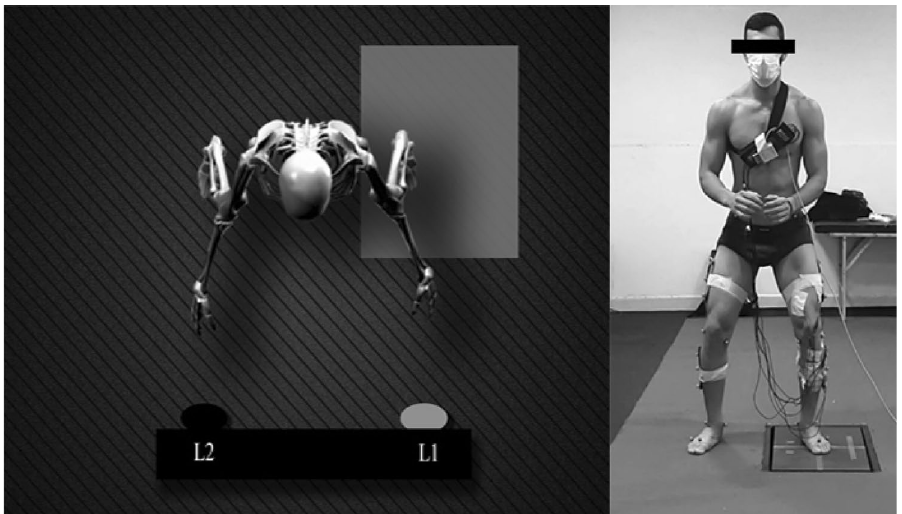
Figure 1. Participants were needed to respond as rapidly as possible to randomly ordered light stimuli for the choice reaction time task. By turning on L1 light, subjects performed a bilateral vertical, landing on the left foot and then jumping as rapidly as possible to the right. The opposite sequence was cued by the L2 light.